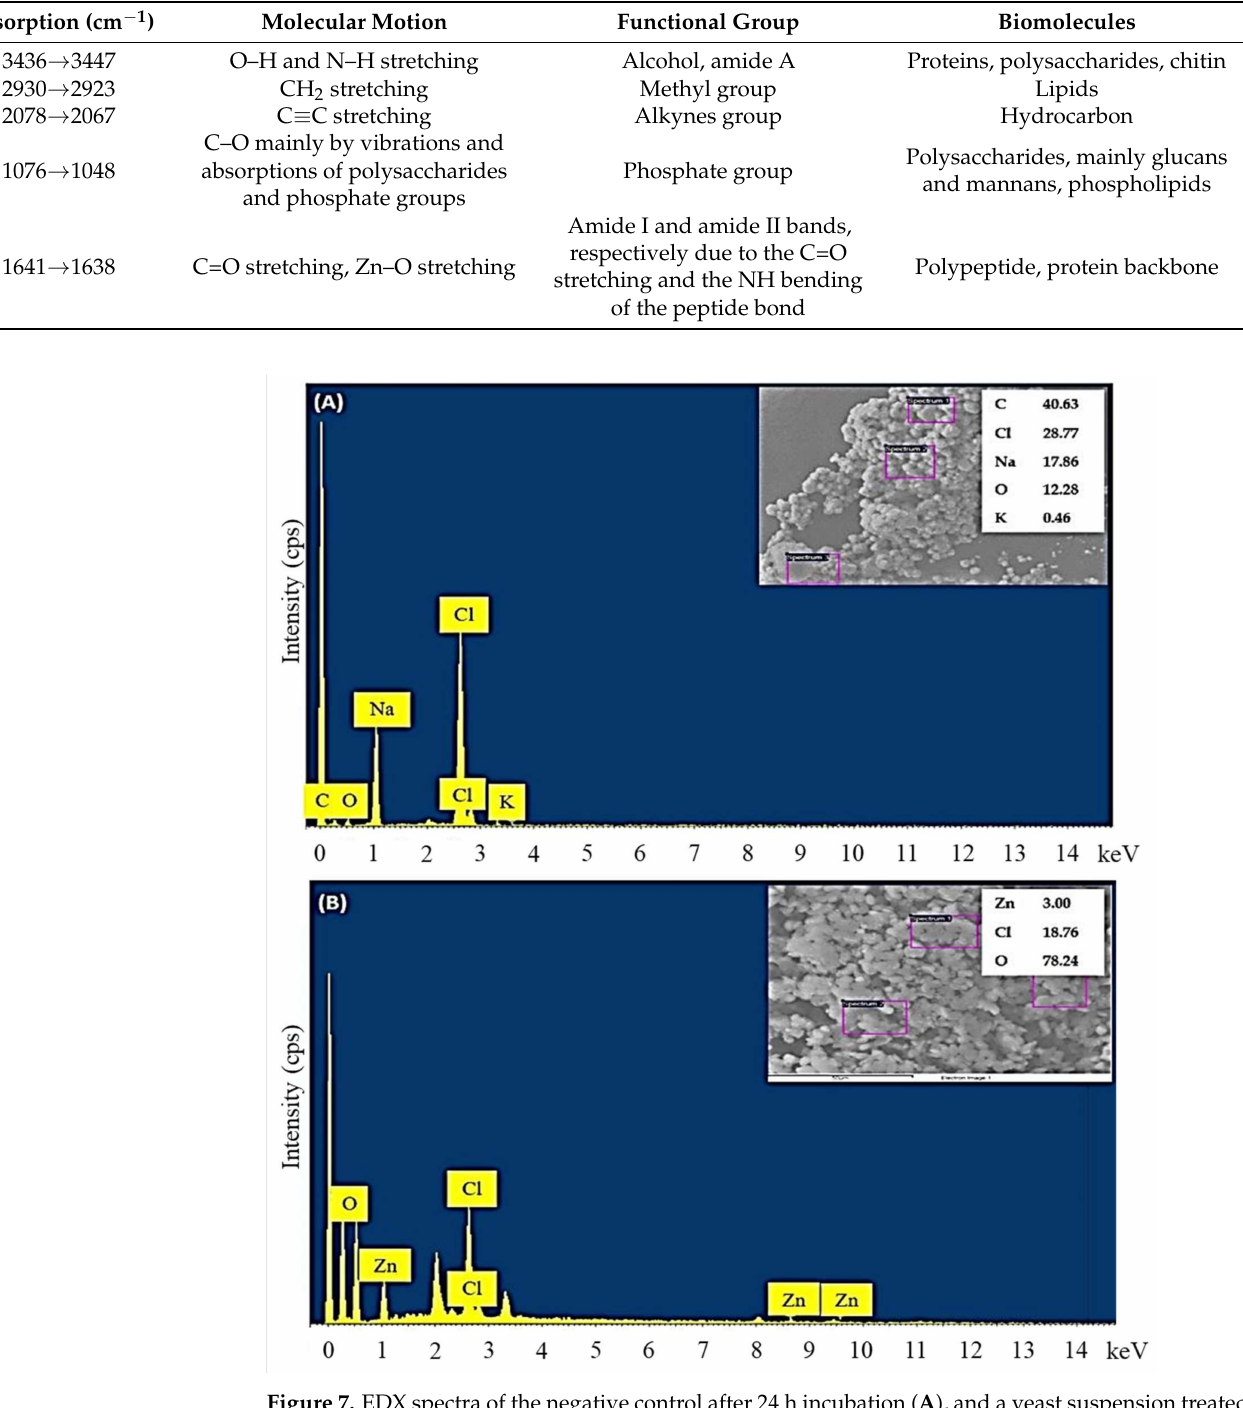
Figure 7. EDX spectra of the negative control after 24 h incubation ( A ), and a yeast suspension treated with 160 µ g/mL ZnO NPs after 24 h of incubation ( B